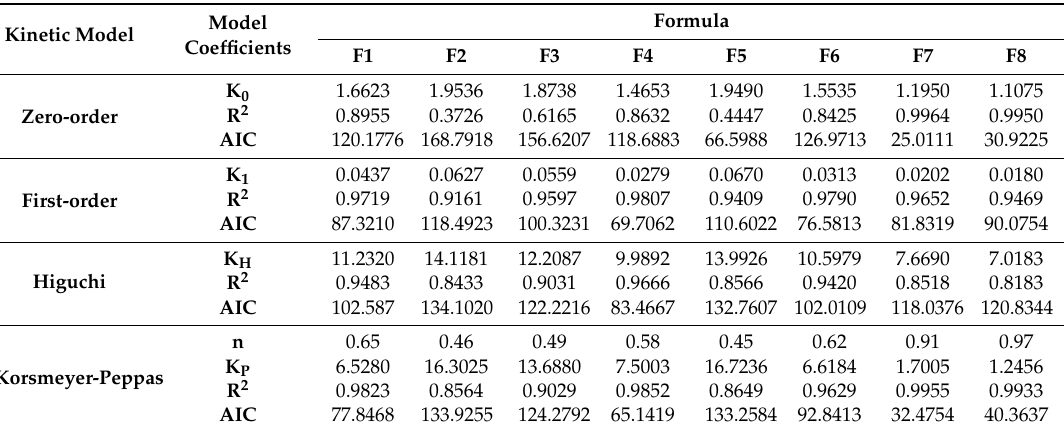
Table 3. Results of curve fitting of the in vitro AL release profile from AL-loaded SLPs in gastrointestinal dissolution media.